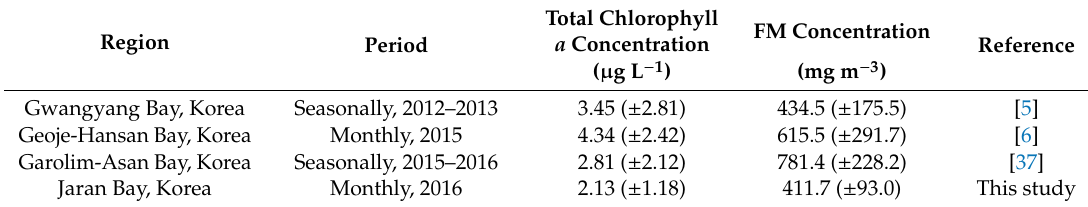
Table 5. Comparison of the total chlorophyll a concentrations and FM concentrations of POM among di ff erent Korean bays. Region Period